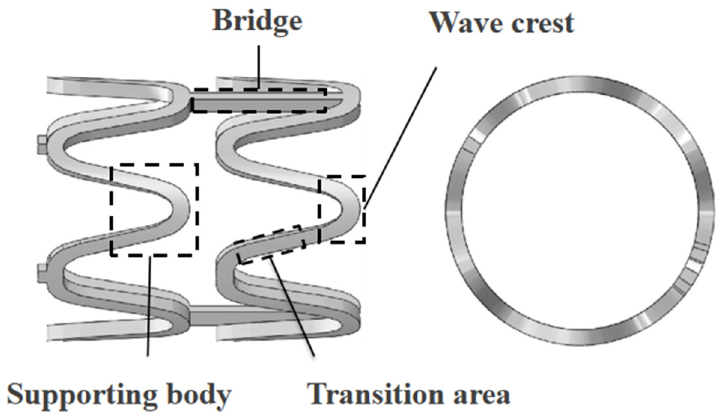
Figure 2. 3D model of Biotech’s L-type coronary artery